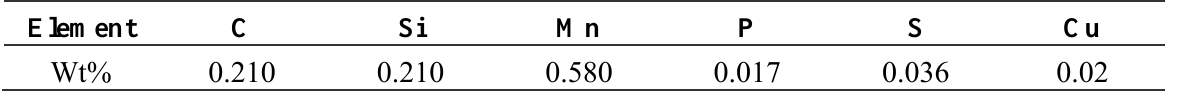
Table 1. Chemical composition of test material.